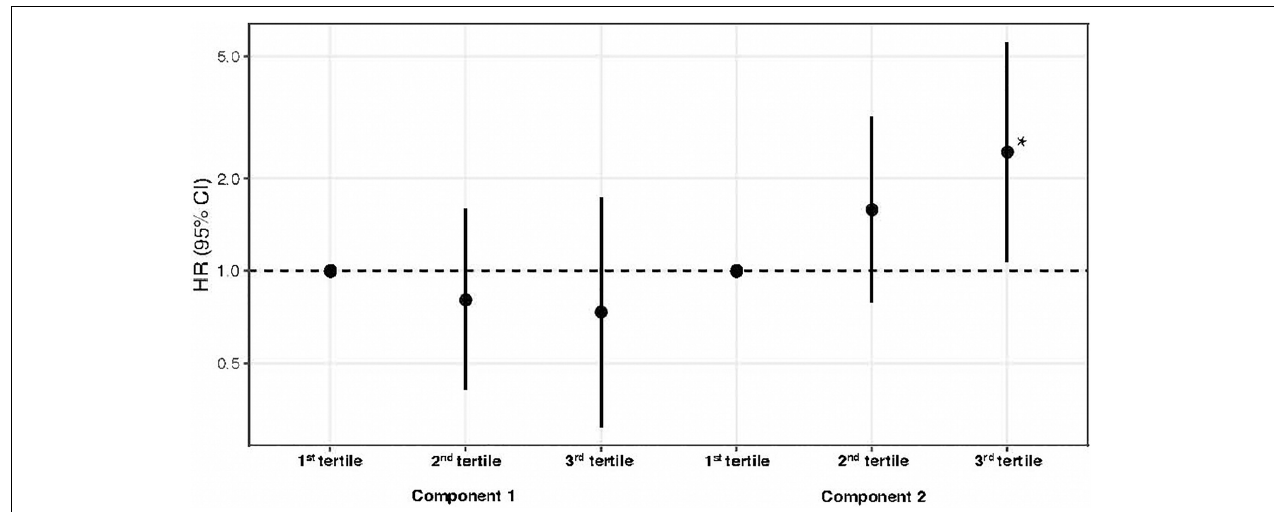
FIGURE 3 | Hazard ratio for recurrent cardiovascular events by tertiles of respiratory polygraphy components in the ISAACC cohort. Dots are hazard ratios, and lines represent 95% confidence intervals. Hazard ratios were adjusted for age, sex, smoking, alcohol consumption, obesity, hypertension, stroke, diabetes, the severity of ACS, dyslipidemia, antihypertensive drugs, antiplatelet and antithrombotic drugs, heart rate, systolic blood pressure, creatinine, stents implanted, cardiovascular event type, troponin peak, and mean SaO 2 . HR (95% CI), hazard ratio (95% confidence interval); ACS, acute coronary syndrome. *Significant p values ( p <